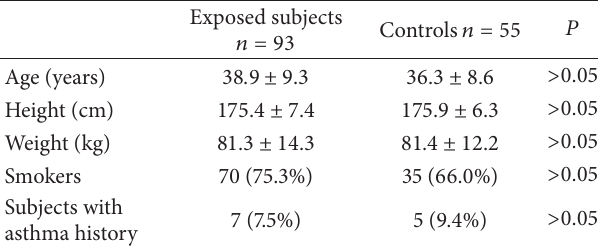
Table 1: Demographic and health aspects of exposed subjects and controls.